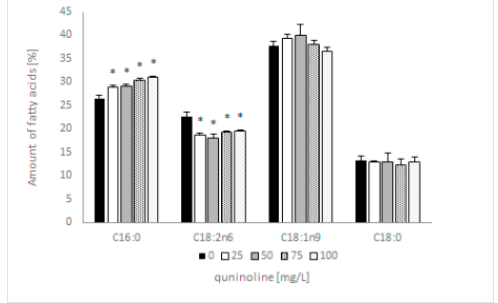
Figure 5. Influence of quinoline on the fatty acid profile of C. lunata IM 4417 determined in the stationary phase of growth. Asterisk ( p < 0.05) indicates values that differ significantly from the control.